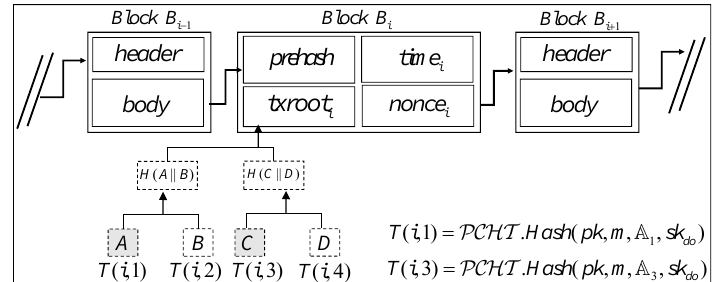
Figure 2. PCHT-based blockchain